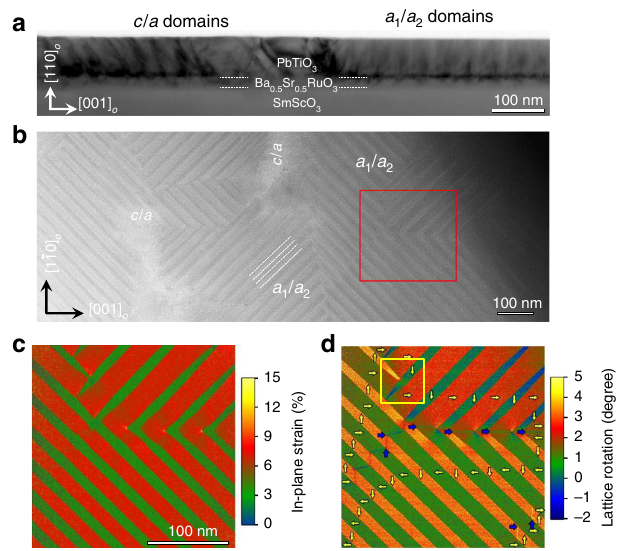
Fig. 1 Domain structures of 70-nm-thick PbTiO 3 fi lms grown on Ba 0.5 Sr 0.5 RuO 3 /SmScO 3 (110) O . a Cross-sectional transmission electron microscopy (TEM) image of the heterostructures where the white dashed lines mark the PbTiO 3 /Ba 0.5 Sr 0.5 RuO 3 and Ba 0.5 Sr 0.5 RuO 3 /SmScO 3 interfaces. b Plan-view high-angle annular dark fi eld-scanning transmission electron microscopy (HAADF-STEM) image of the heterostructure where the dashed lines indicate the a 1 / a 2 domain walls. c In-plane strain map ( ε xx ) and d lattice rotation map ( ω ) extracted from the HAADF-STEM lattice image via geometrical phase analysis (GPA) for the area in the red square in ( b ). The yellow arrows indicate the head-to-tail structures and the blue arrows indicate 180° domain walls. The lattice rotation at 180° domain walls can be used to identify the polarization directions beside the domain walls. Yellow-border square in ( d ) reveals relatively large fl